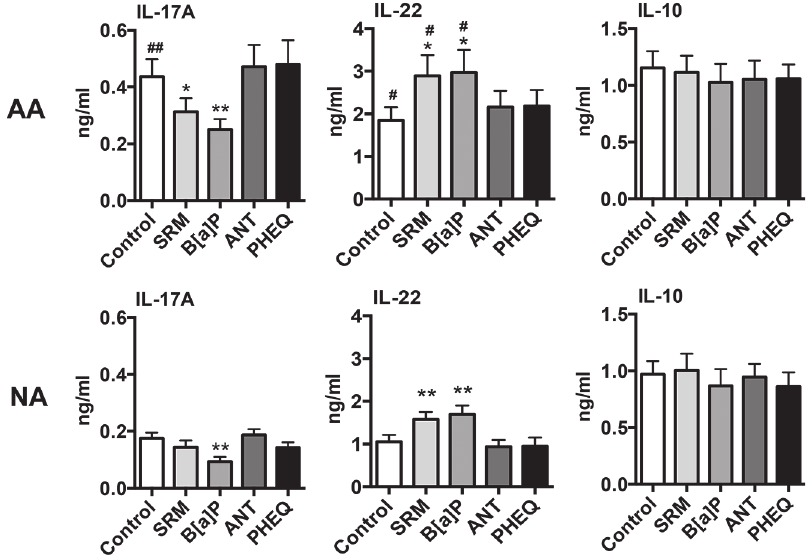
Fig 2. Cytokine profile of PAH-stimulated peripheral blood mononuclear cells in allergic asthmatics (AA) and nonallergic subjects (NA). IL-17A, IL-22 and IL-10 secretion by activated peripheral blood mononuclear cells from NA subjects (n = 10) and AA patients (n = 12) stimulated or not with different PAH for 72hr was determined by ELISA. Results are expressed as mean ± SEM. * P < .05 and ** P < .01 versus control. # P < .05 and ## P < .01 AA versus NA